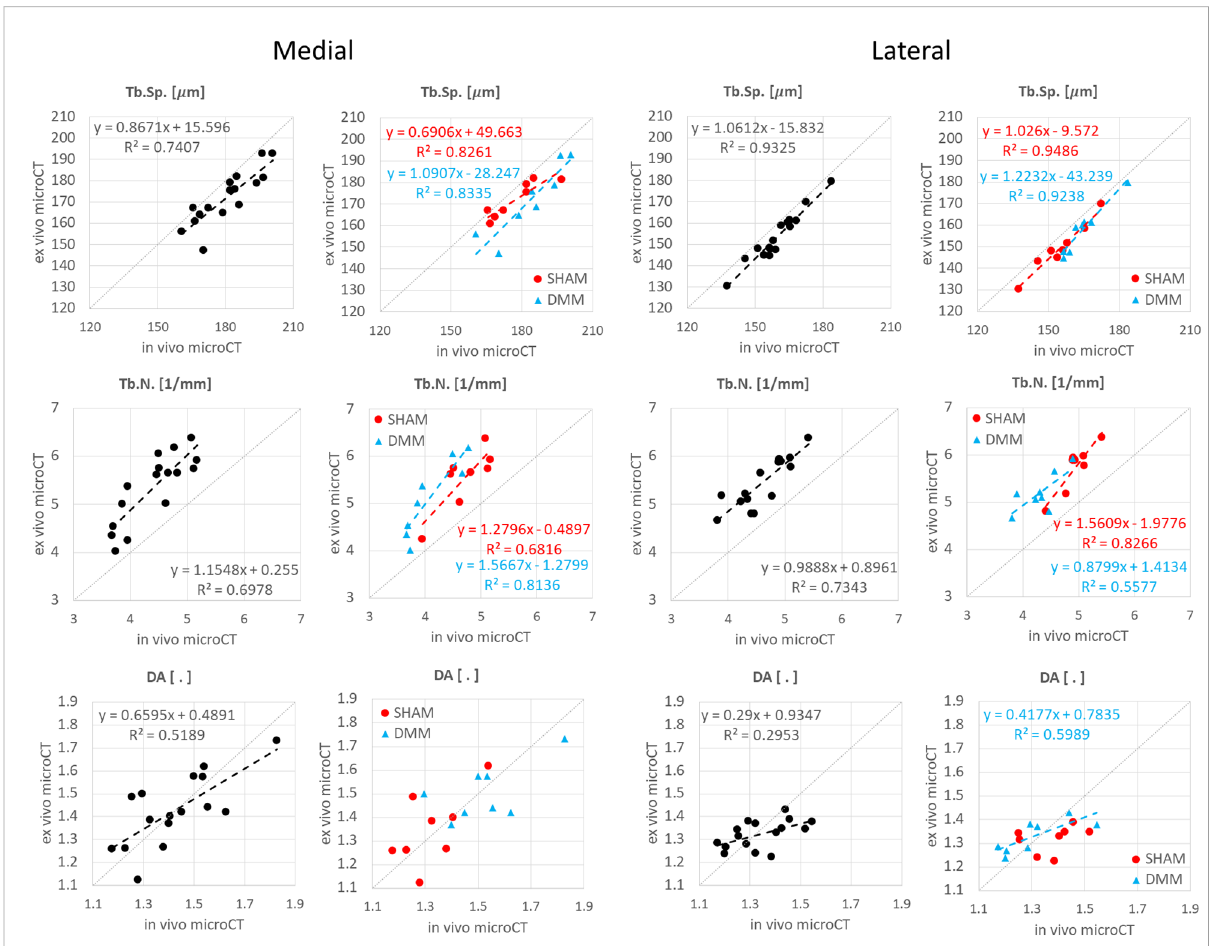
FIGURE A2 Regression analyses between in vivo and ex vivo measurements for trabecular separation (Tb.Sp), number (Tb.N) and degree of anisotropy (DA) in the medial and lateral